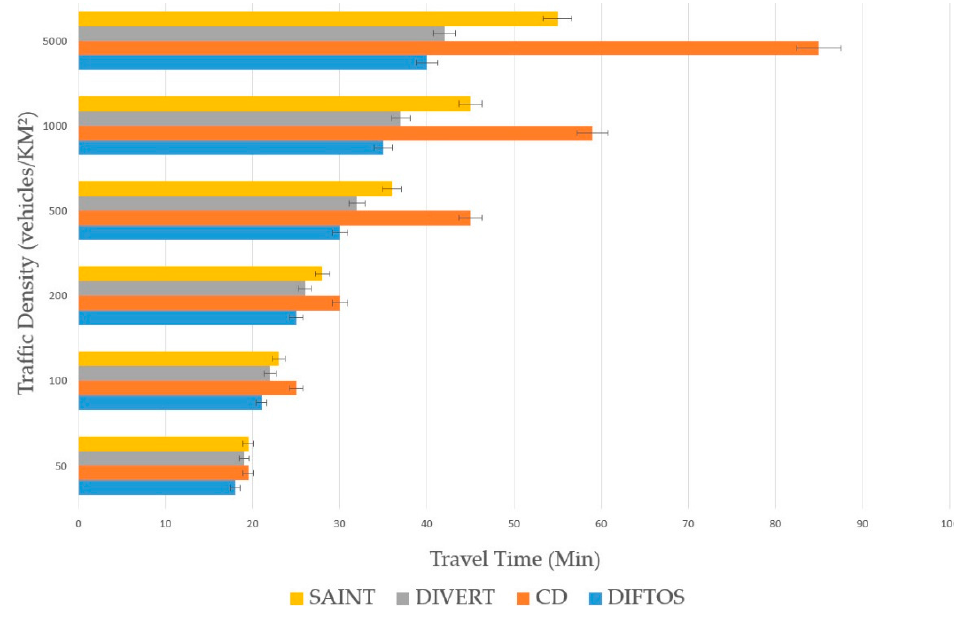
Figure 7. Traffic density vs. travel time.